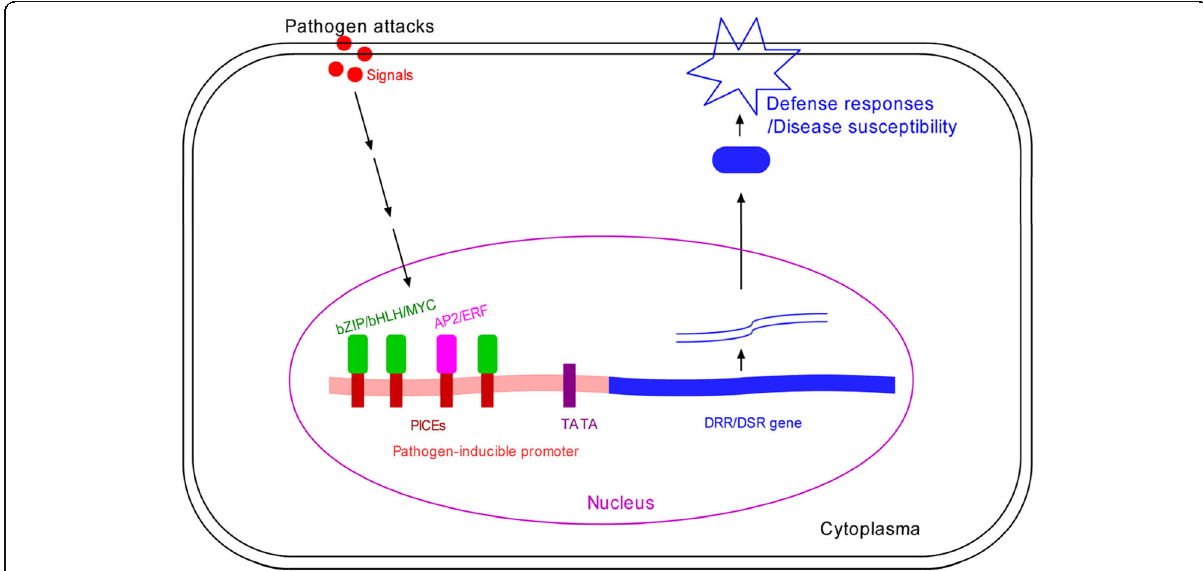
Fig. 6 A working model for rice DRR/DSR genes under the governing of a pathogen-inducible promoter with the PICEs. DRR/DSR gene: disease resistance/susceptibility-related